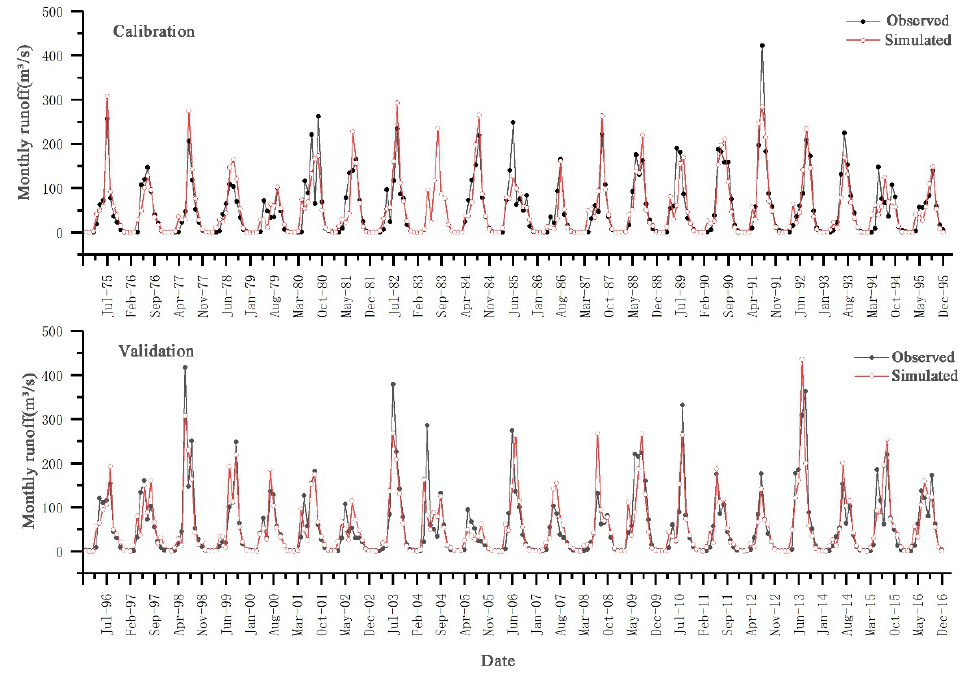
Figure 2. Comparison between simulated and measured monthly runoff in calibration and validation period.